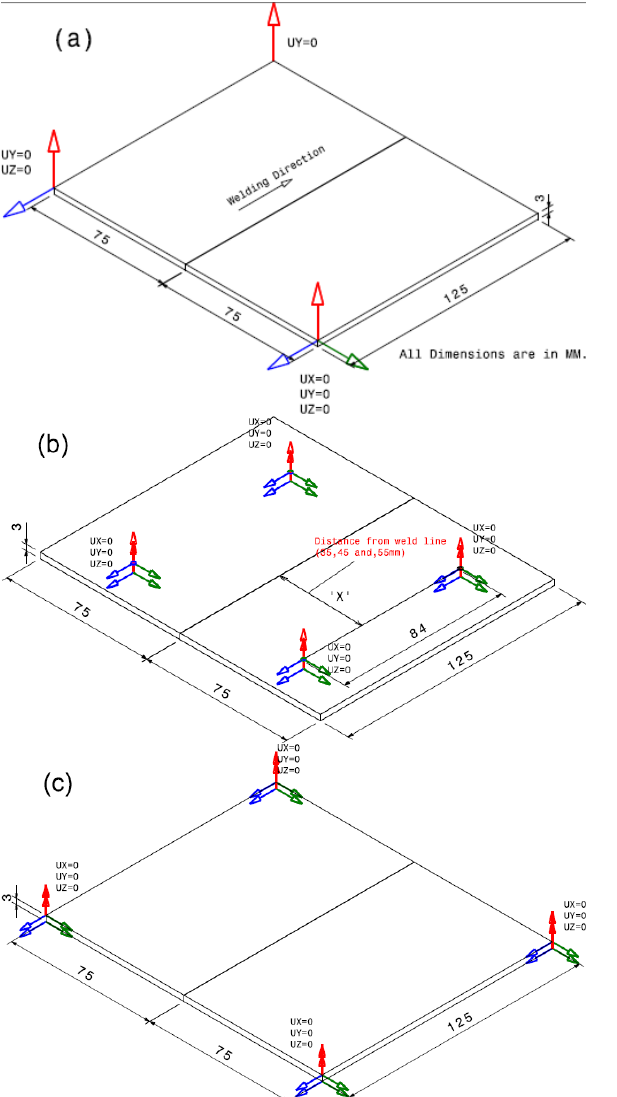
Figure 4: Boundary conditions for mechanical analysis: (a) No constraint (Prevent Rigid body motion) (b) fully constraint at mid nodes and (c) fully constraint at corner nodes.